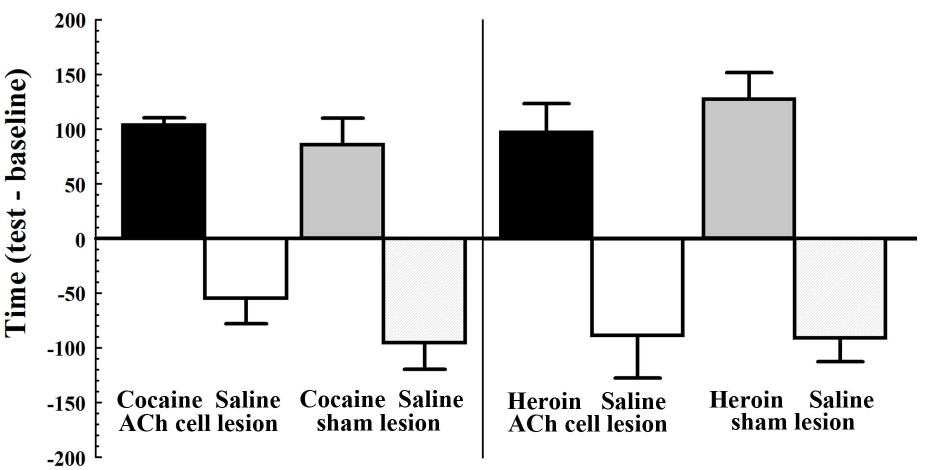
Figure 2. Cocaine or heroin conditioned place preferences are not altered by bilateral pedunculopontine tegmental nucleus (PPTg) cholinergic cell loss. For cocaine conditioned place preference (20 mg/kg; i.p.; left) PPTg cholinergic cell-lesioned rats (black bar; n=4) and sham- lesioned rats (gray bar; n=4) each showed a significant increase in the amount of time spent in the cocaine-paired chamber as a result of place conditioning. For heroin conditioned place preference (0.5 mg/kg; i.p.; right) PPTg cholinergic cell-lesioned rats (black bar; n=6) and sham-lesioned (gray bar; n=5) each showed a significant increase in the amount of time spent in the heroin-paired chamber as a result of place conditioning. Error bars represent 6 SEM.